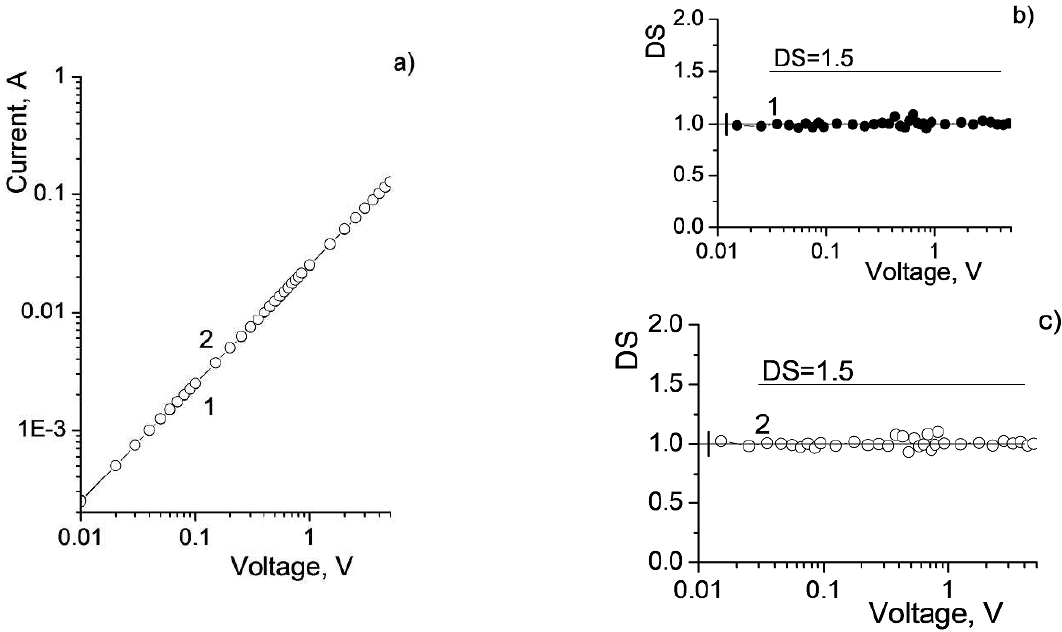
Figure 7. ( a ) Current–voltage characteristics (CVCs) of 10 min ‐ deposited sulfacyl sodium on carbon substrate 2 in the dark and under illumination; ( b , c ) dimensionless sensitivities (DS) of CVCs.